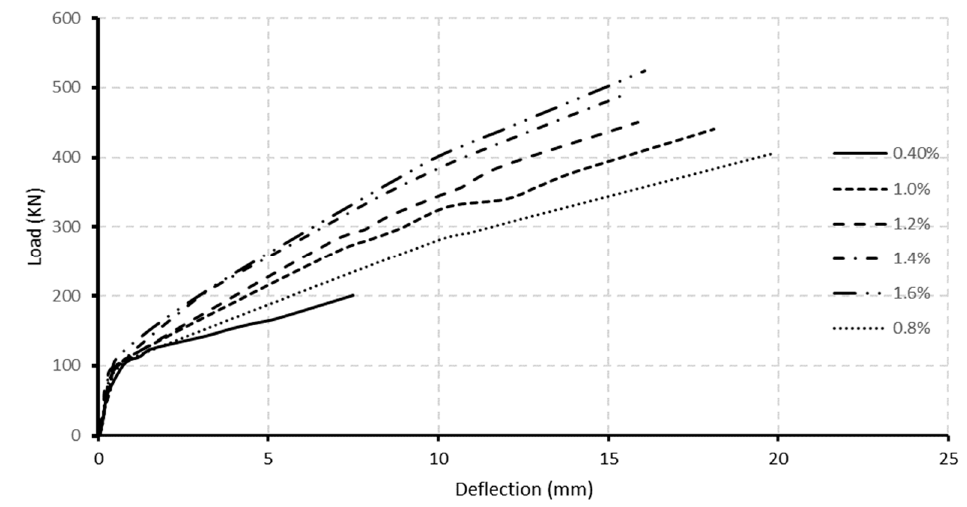
Figure 15. Load–deflection curve for variable longitudinal reinforcement ratio for normal concrete strength beam specimens (40 MPa).